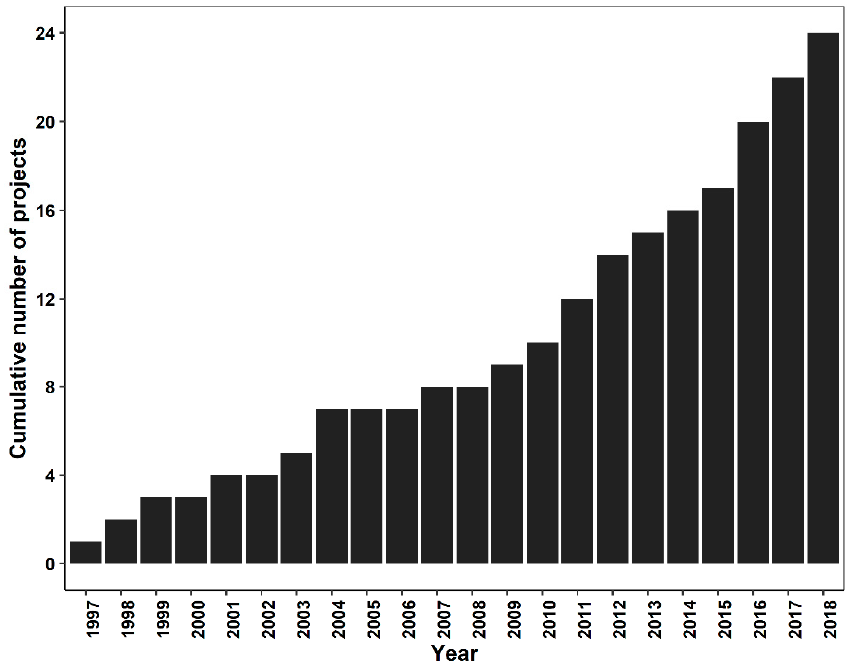
Figure 3. Cumulative number of desalination projects approved per year in Chile between 1997 and 2018.